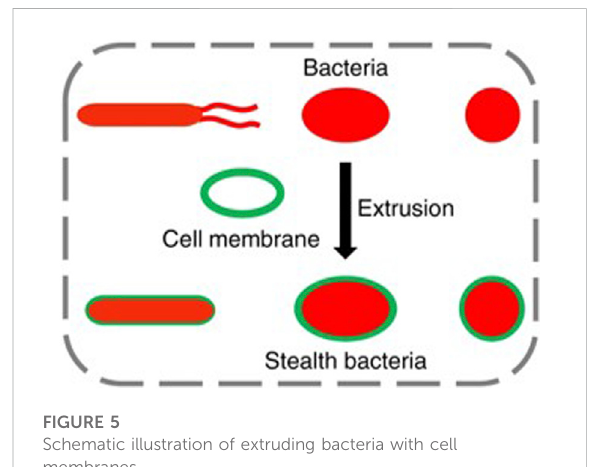
FIGURE 5 Schematic illustration of extruding bacteria with cell membranes.